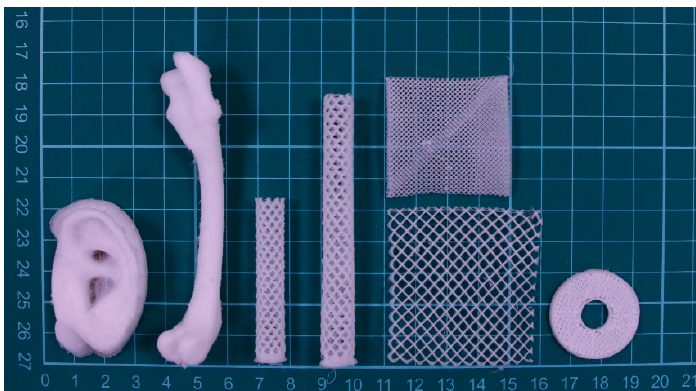
Figure 13. Various PCL parts additively manufactured using the optimum processing conditions.